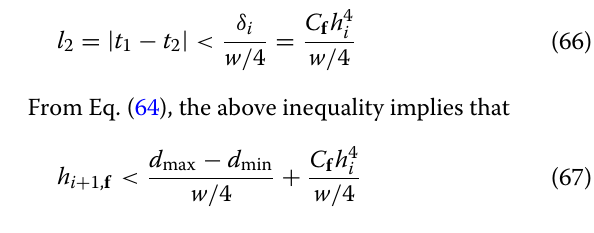
algorithm have second- and fourth-order convergence rates, respectively, and the 3D curve intersection prob- lem yields the same results. Experimental results